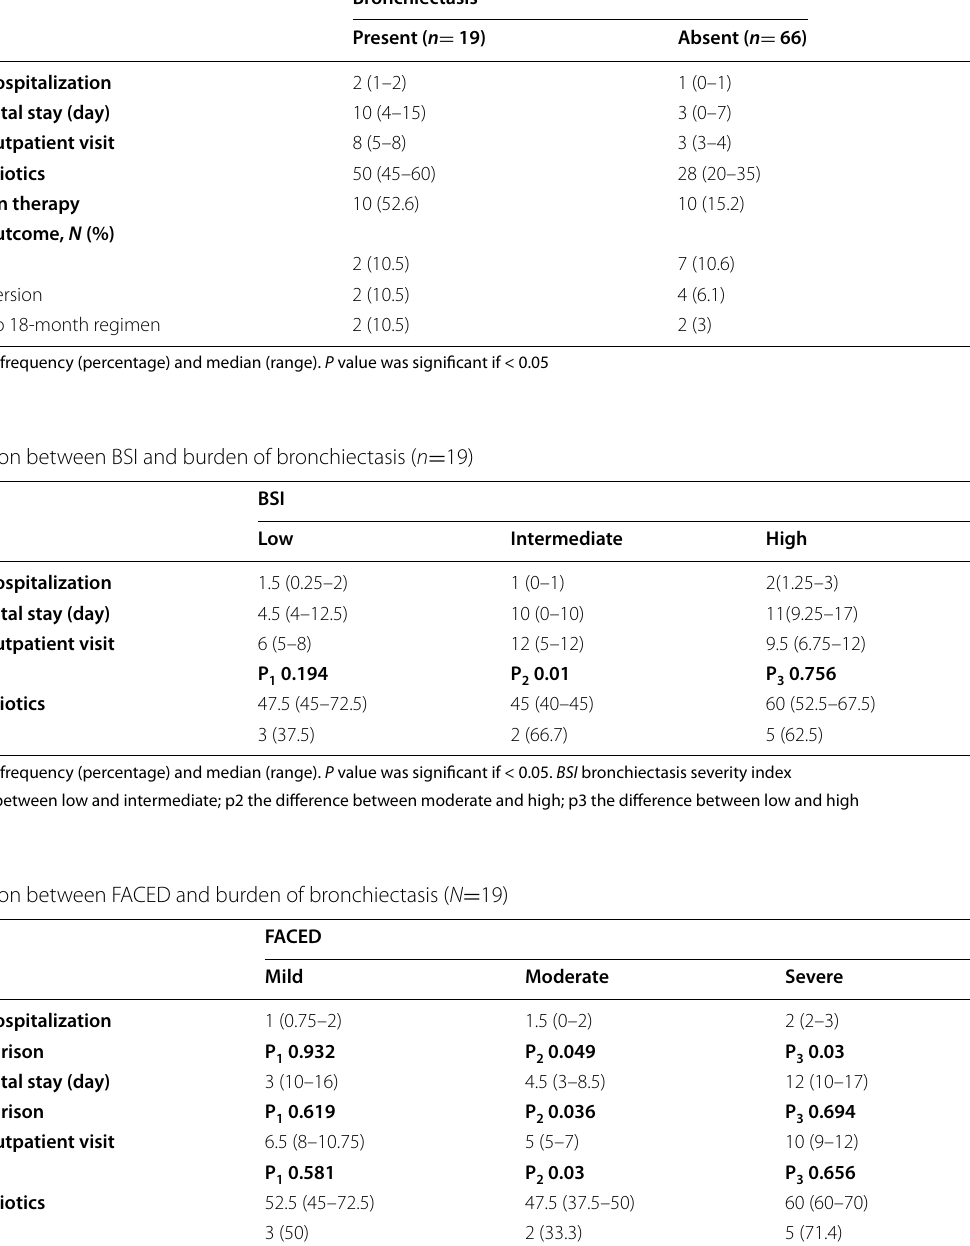
Data expressed as frequency (percentage) and median (range). P value was significant if < 0.05. FACED Fev1/Age/Colonization/Extension/Dyspnea score for bronchiectasis severity p1 the difference between low and intermediate; p2 the difference between moderate and high; and p3 the difference between low and